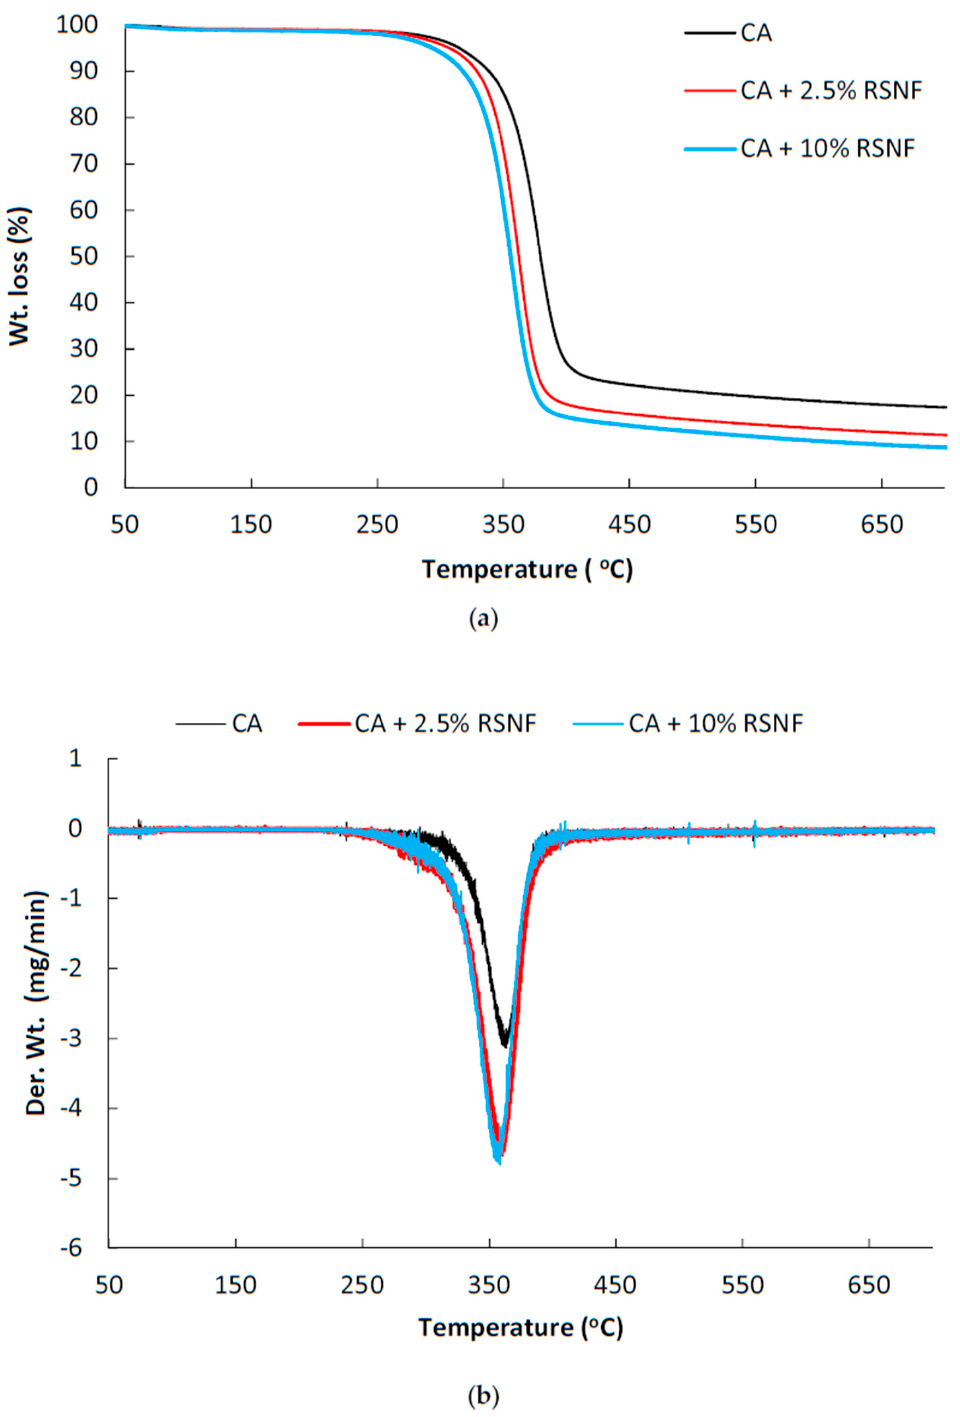
Figure 10. TGA and differential thermogravimetric analysis (DTGA) curves of ( a ) CA and ( b ) CA/RSNF films.